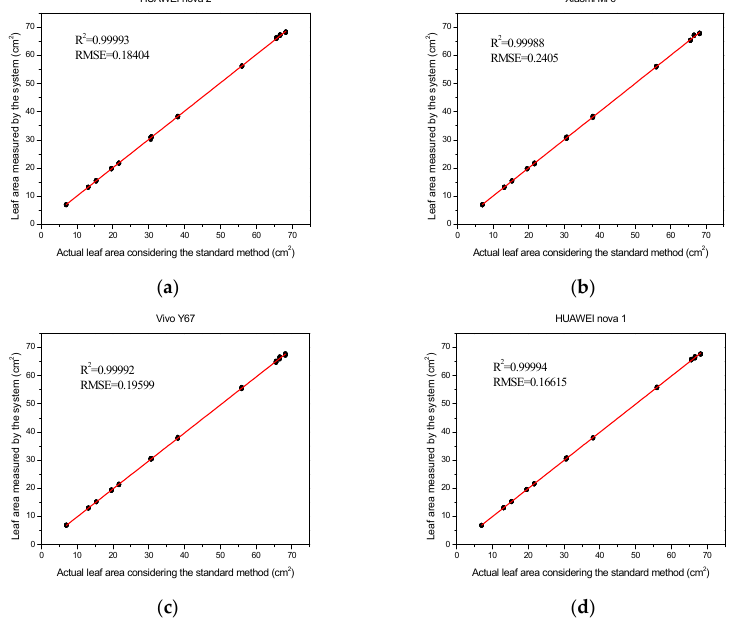
Figure 13. The relationship between leaf geometric parameters measured by the traditional method and by the developed system. ( a ) HUAWEI nova 2; ( b ) Xiaomi Mi6; ( c ) Vivo Y67; and ( d ) HUAWEI nova 1.